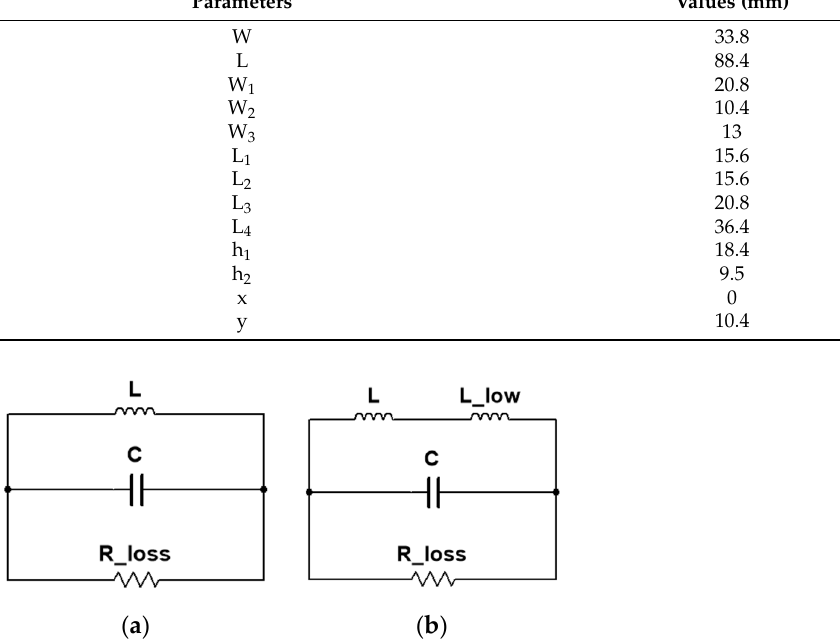
Figure 2. Wideband mechanism of the proposed F-shaped patch: ( a ) RLC resonance for 2.45 GHz and ( b ) dual RLC resonance including the effect of the slot.